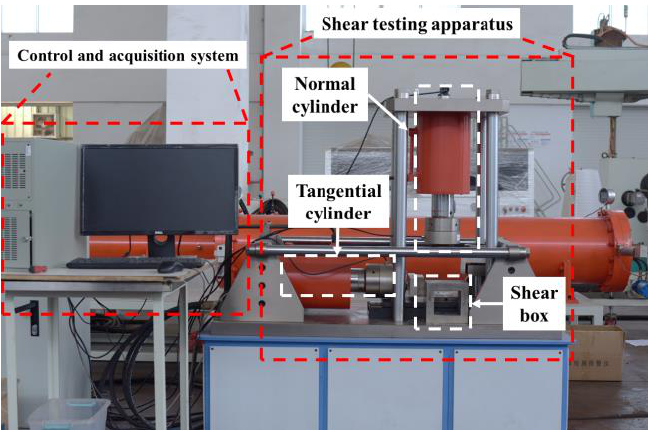
Figure 4. Test equipment diagram.